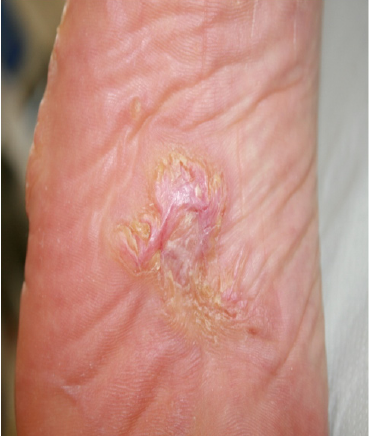
Figure 1. Proteus syndrome: Modestly developed connective tissue nevus of the left foot, previously misdiagnosed as a keloid.